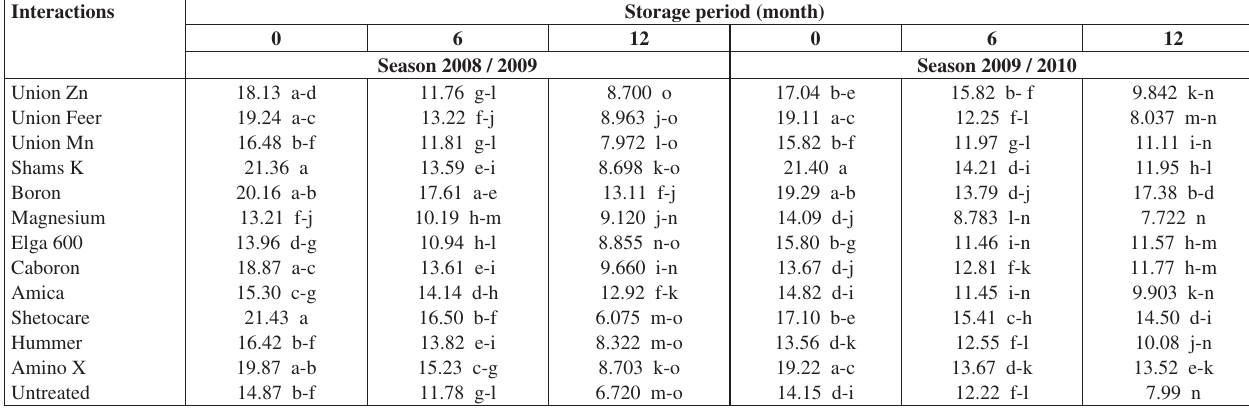
2008/2009 season